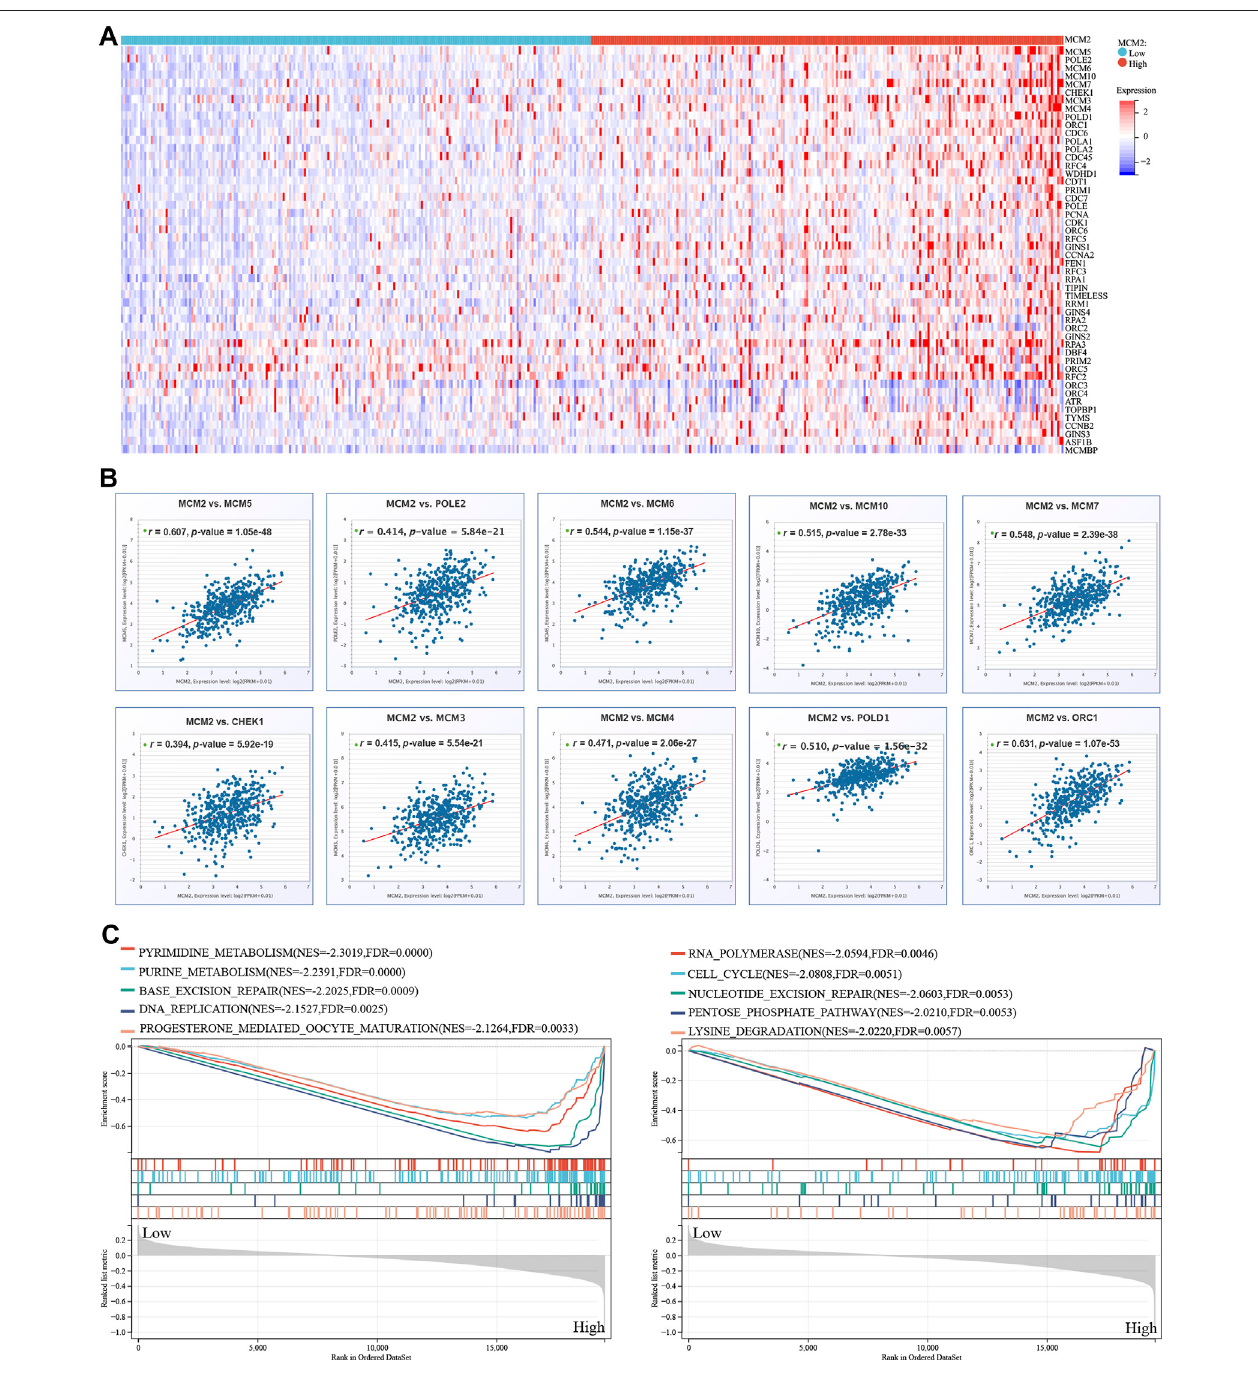
FIGURE 11 | MCM2 in SKCM. (A) The top 50 genes with positive co-expression of MCM2 in the TCGA database of SKCM according to the heatmap. (B) The top 10geneswithastrongpositivecorrelationwithMCM2 inSKCM. (C) GSEAshowingthatMCM2 expressionwasassociatedwith10pathwaysinTCGA SKCMsamples.